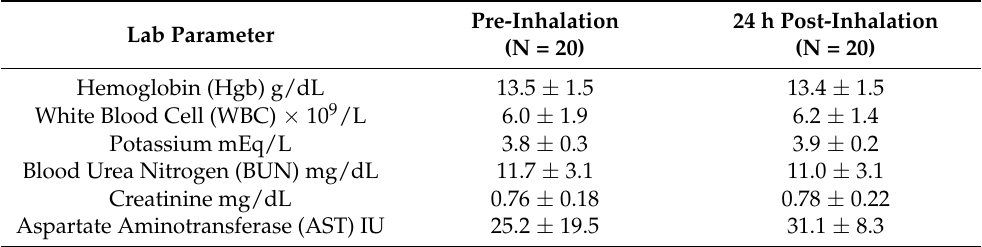
Table 1. Baseline and 24 h post-inhalation laboratory data with nebulized TAC-LAC (3 mg TAC/dose).